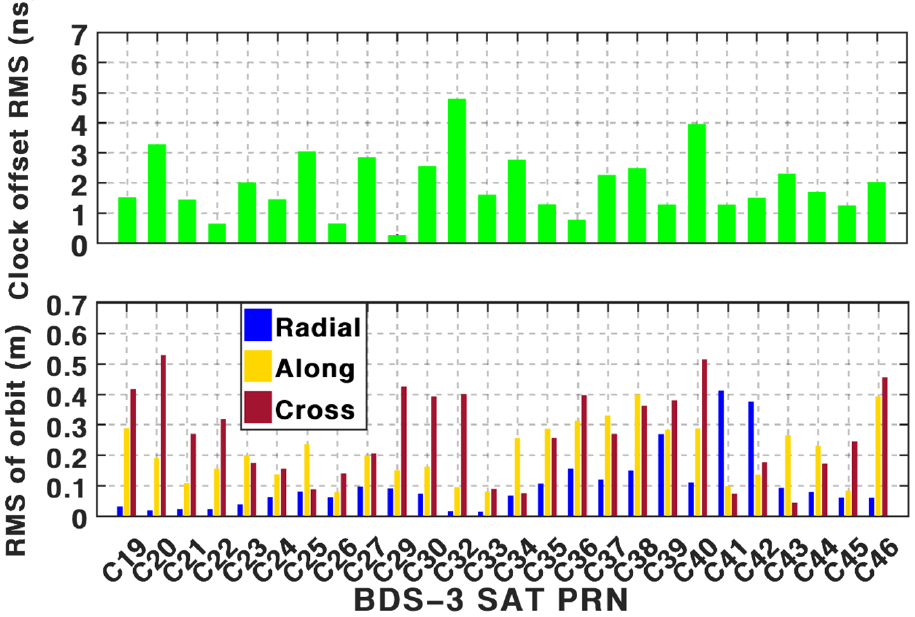
Figure 5. RMS of BDS-3 clock offset and orbit errors of real-time products recovered by PPP-B2b service. Table 1. Mean RMS of orbit errors and clock offset of real-time products recovered by PPP-B2b service.